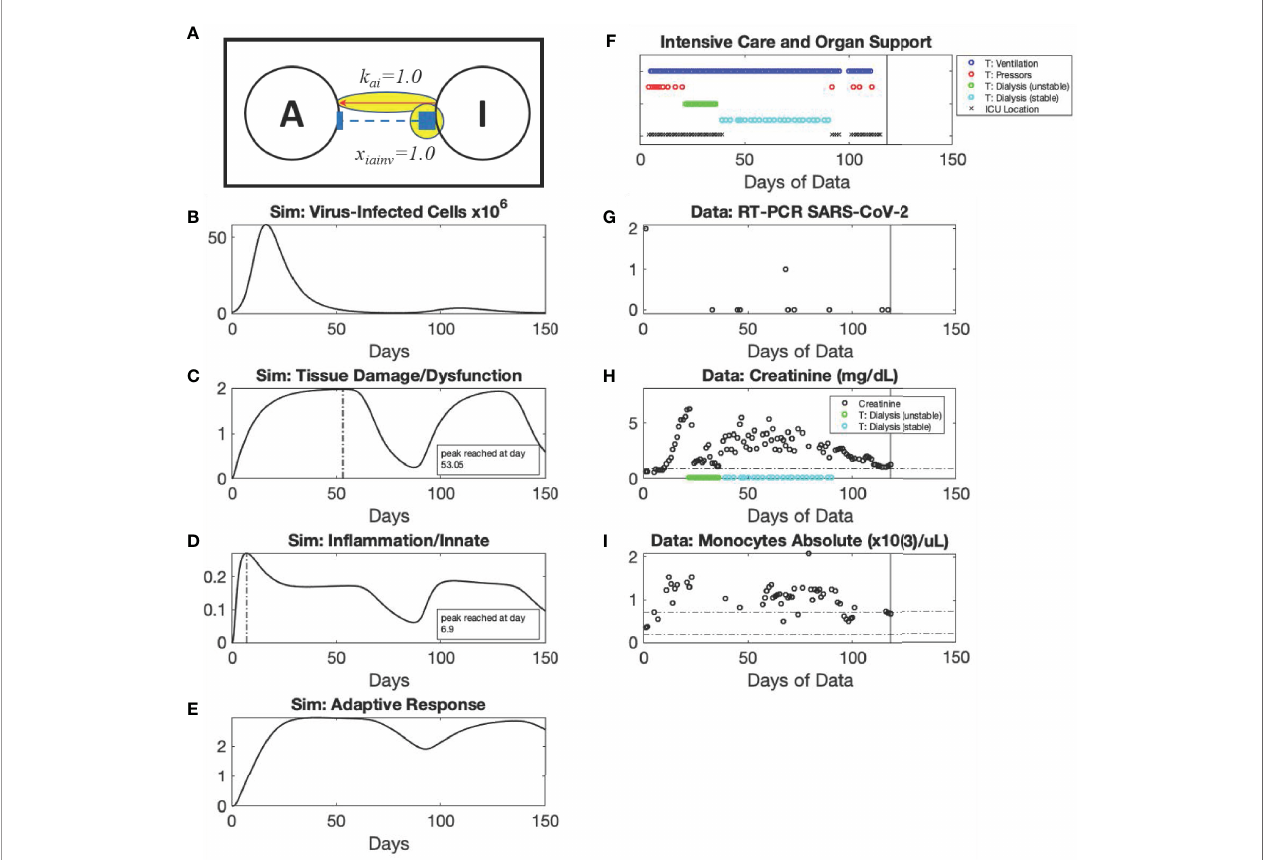
FIGURE 7 | Recrudescence archetype, Long-lasting Disease scenario: simulation vs . patient data. Using modi fi ed values of parameters k ai and x iainv compared to the Recovery archetype, Mild scenario as shown in the diagram (Panel A ), simulated dynamics are shown of C V (Panel B ) (Initialized with a C V =8x10 5 virus-infected cells), D (Panel C ), I (Panel D ), and A (Panel E ). Panels (F – I) show data from a patient in their 60s with diabetes and hypertension who presented with pneumonia and SARS-CoV-2 positivity. The patient ’ s course had two distinct periods of critical illness. They required intubation by Hospital Day 5, and their course was complicated by vasopressor-dependent hypotension and renal failure requiring continuous venovenous hemodialysis from Hospital Days 23-38. The patient was able to leave the intensive care unit on Hospital Day 39 but returned to intensive care on Hospital Day 92 with new hypotension requiring vasopressors, status epilepticus, and ischemic stroke. The patient was ventilator-independent by Hospital Day 95, recovered renal function, and was able to be discharged to a skilled nursing facility on Hospital Day 118 (black vertical